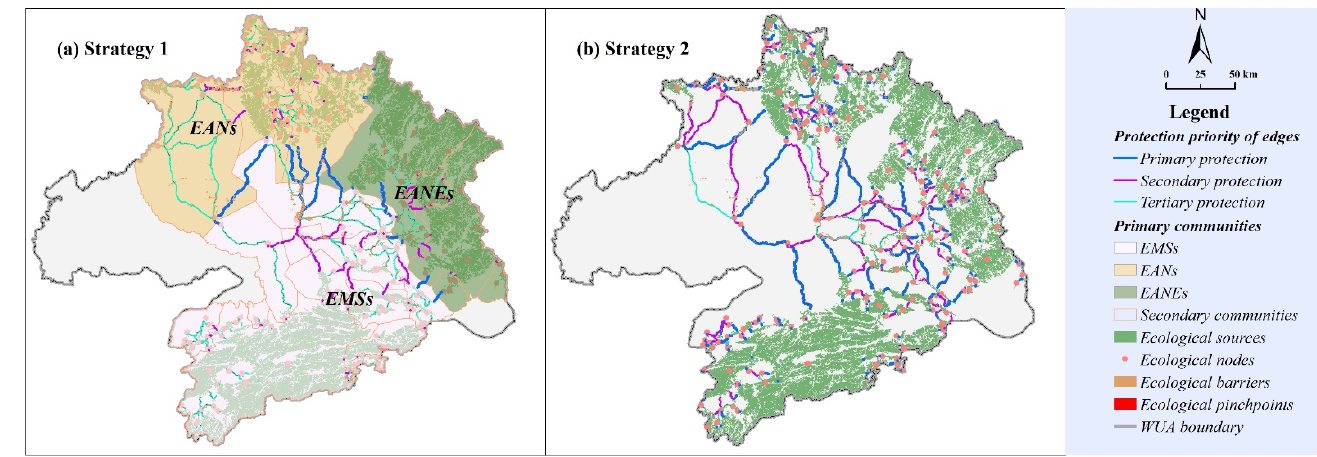
Figure 14. Protection strategies of ecological corridors in WUA.